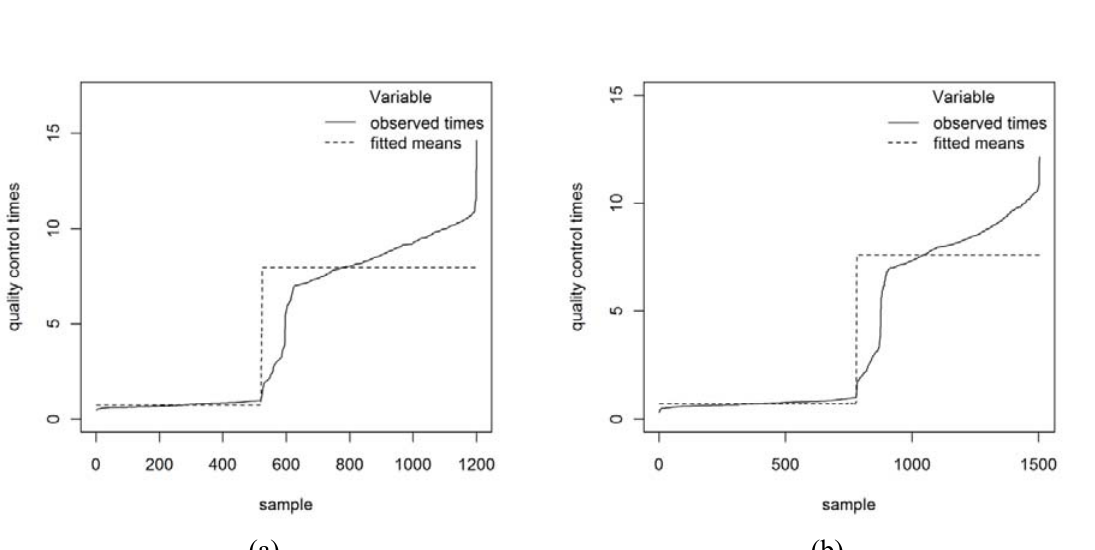
Fig. 6. Quality control times and fitted means versus samples: (a) Analyst 1 and (b) Analyst